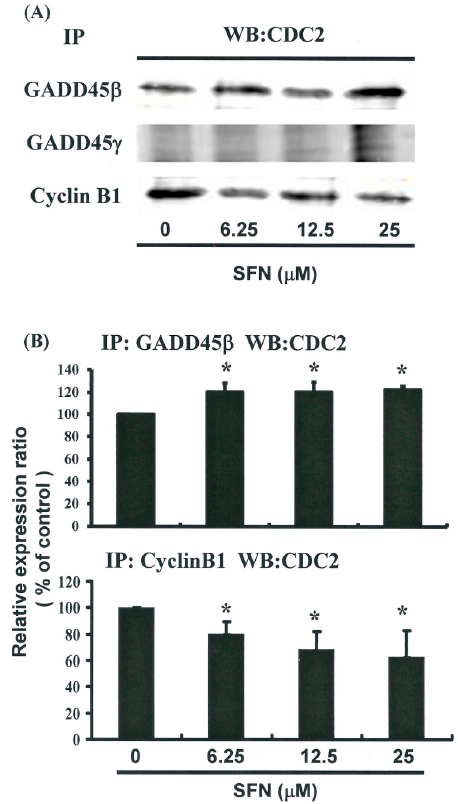
Figure 6. Influence of SFN on the association between CDC2 and GADD45- β /- γ in HeLa cells: ( A ) Co-IP of Cyclin B1, GADD45- β , and GADD45- γ with CDC2 in HeLa cells which had been treated with SFN for 24 h; ( B ) Quantification of band intensities. All data were reported is the mean (±SEM) of at least three separate experiments. Statistical analysis was performed using a t -test, with differences considered significant at a level of * p < 0.05 versus the 0 μ M control group.